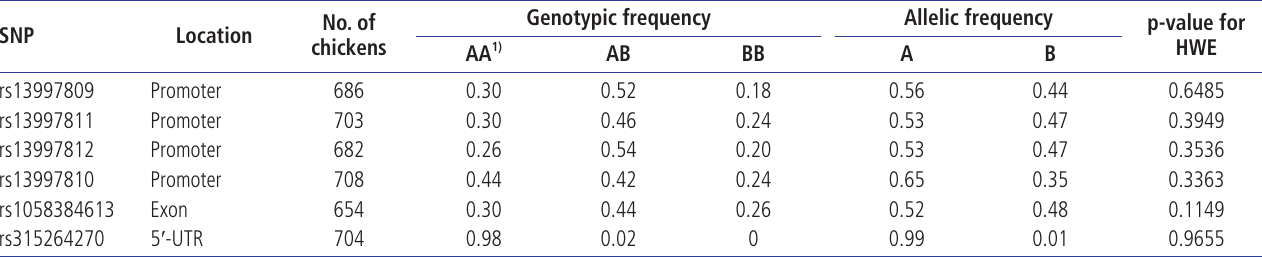
Table 3. Genotypic and allelic frequency of SNPs in UCP3 and Hardy-Weinberg equilibrium test SNP Location